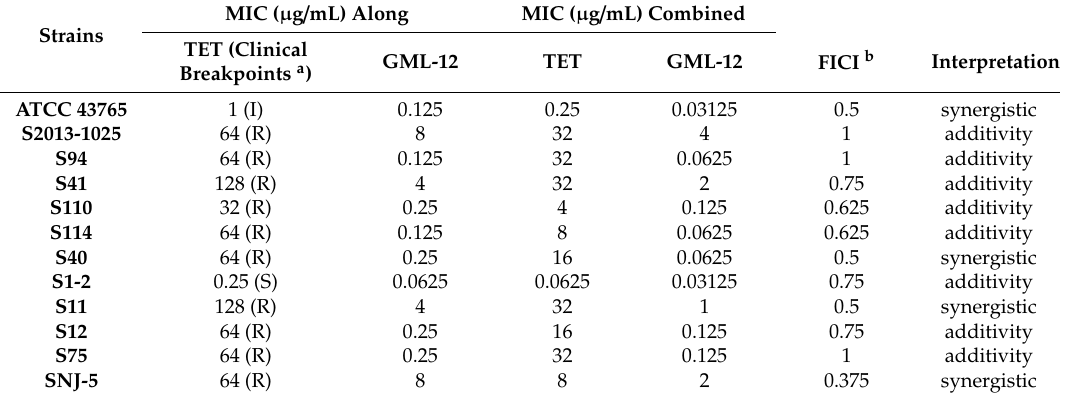
Table 1. Summary of MIC values of GML-12 and TET, alone and in combination, against S. suis strains. Strains